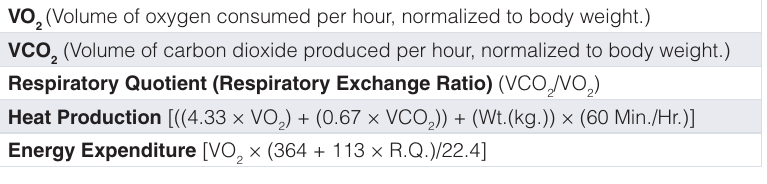
Supplemental Table II a. Legend for indirect calorimetry-based metabolic dependent �ariables. VO (Volume of oxygen consumed per hour, normalized to body weight.) 2 VCO (Volume of carbon dioxide produced per hour, normalized to body weight.) 2